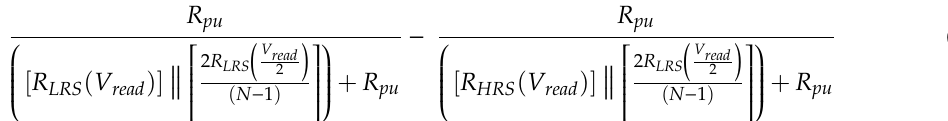
Figure 7. Nonlinear characteristics of TiN/Ti/TiO 2 /SiO x /Si device: ( a ) I–V curve with high selectivity in LRS pulse schemes; ( b ) half-bias scheme in cross-point array structure; ( c ) read margin as a function of number of word lines; energy band diagrams at ( d ) low voltage and ( e ) high voltage; ( f ) ln(I/V 2 ) versus 1/V plot for Fowler–Nordheim (FN) tunnel fitting.